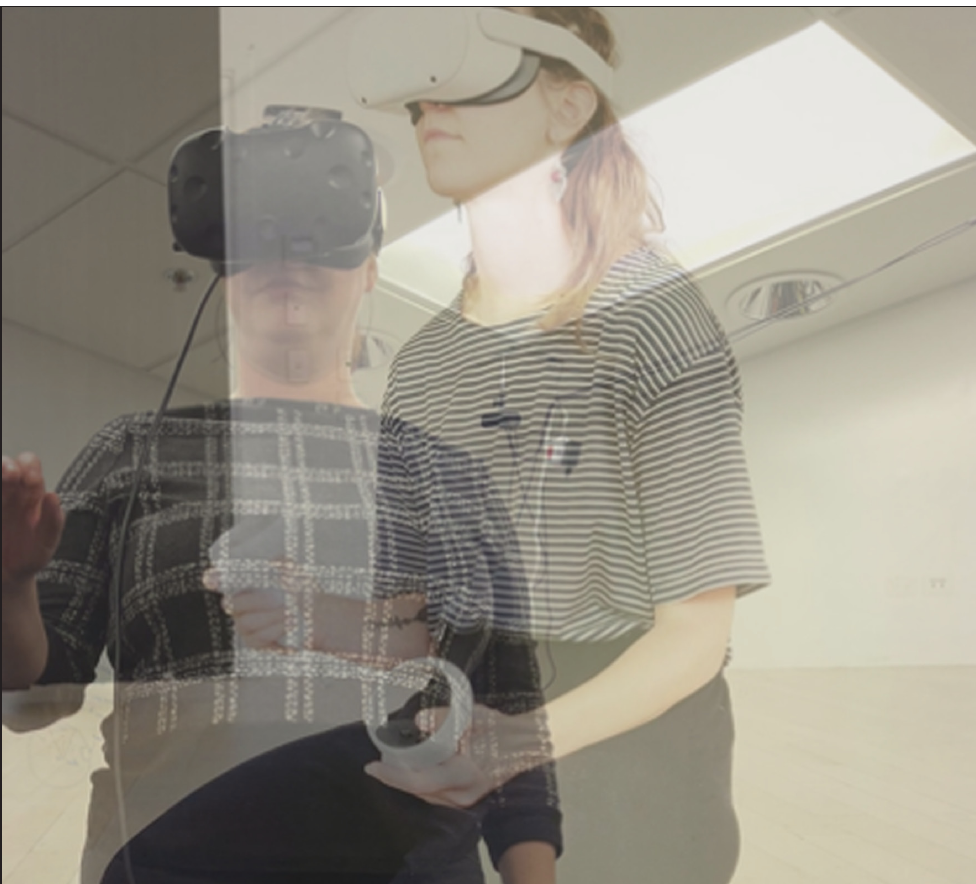
Figure 1: Layering